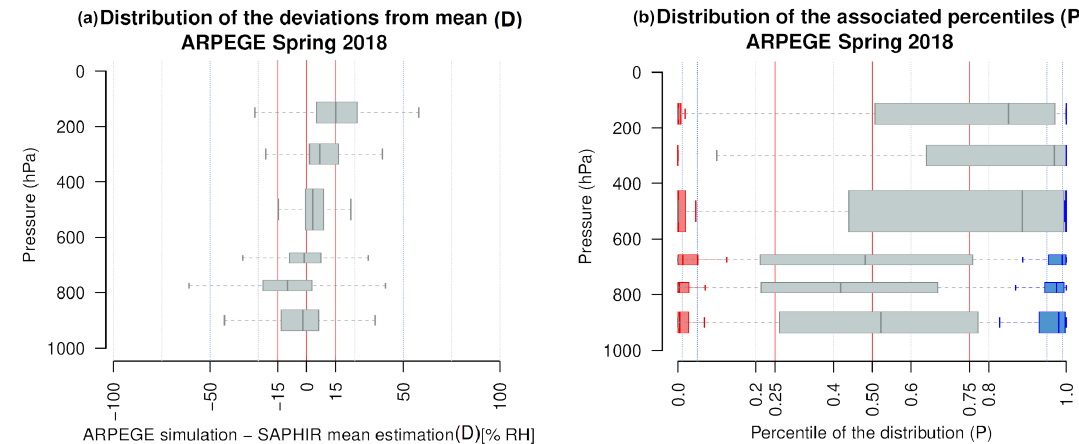
Figure 7. Distribution the results of each method of comparison applied over the period April to June 2018 represented as boxplots for each layer: (a) deviations D from mean and (b) associated percentiles P divided into three distribution types depending on the category of D (red: D < − 15%RH; gray: − 15%RH ≤ D ≤ 15%RH; blue: D > 15%RH). The weights of each category within their layer’s distribution are indicated in Table 1. Table 1. Part (in percent) of the distributions within the three categories of differences D for each atmospheric